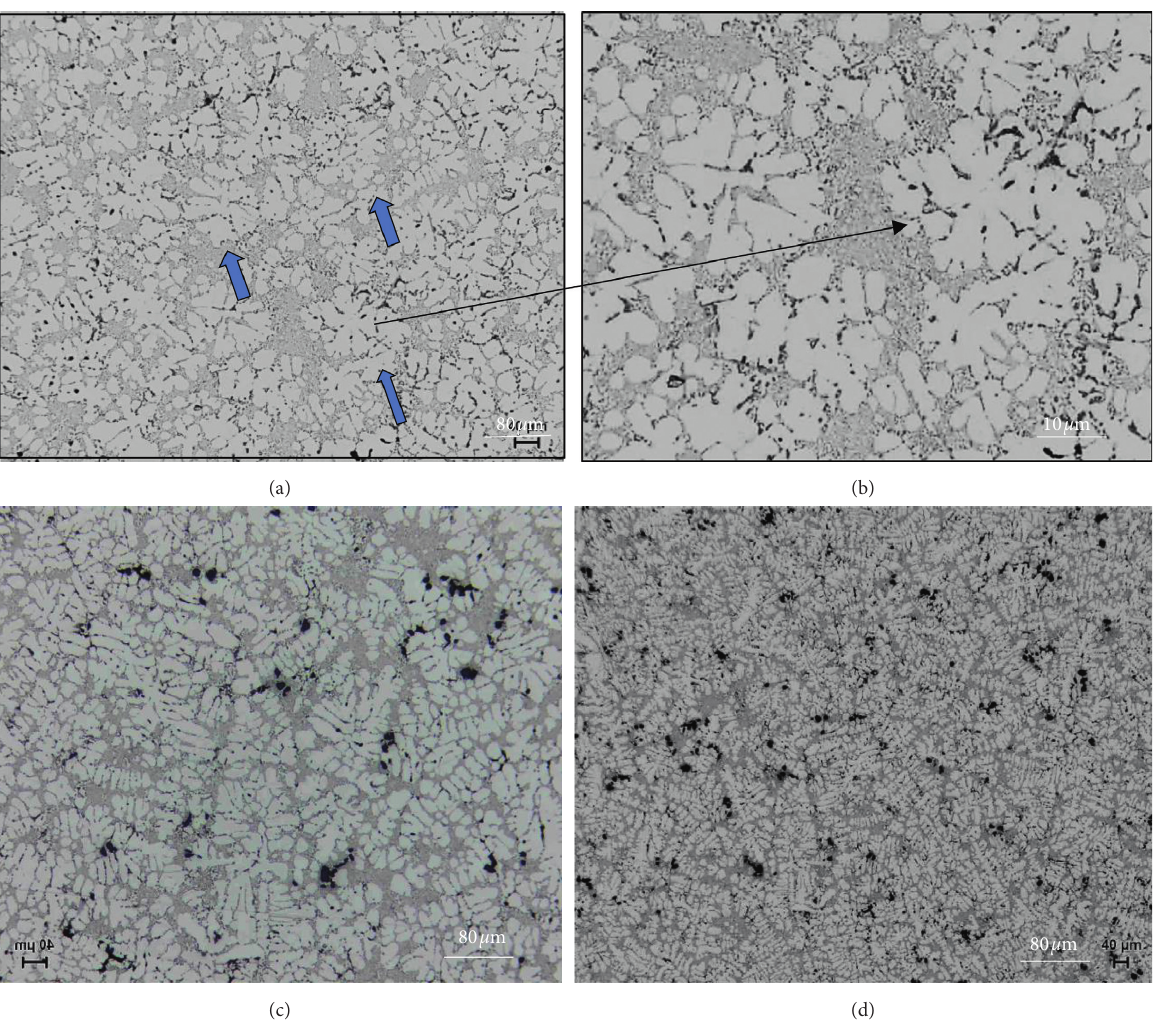
Figure 2: Optical microstructures of (a)alloy A, ascast, (b)a high-magnification micrographof (a),(c) compositeB-SHT,and (d)composite C-SHT.